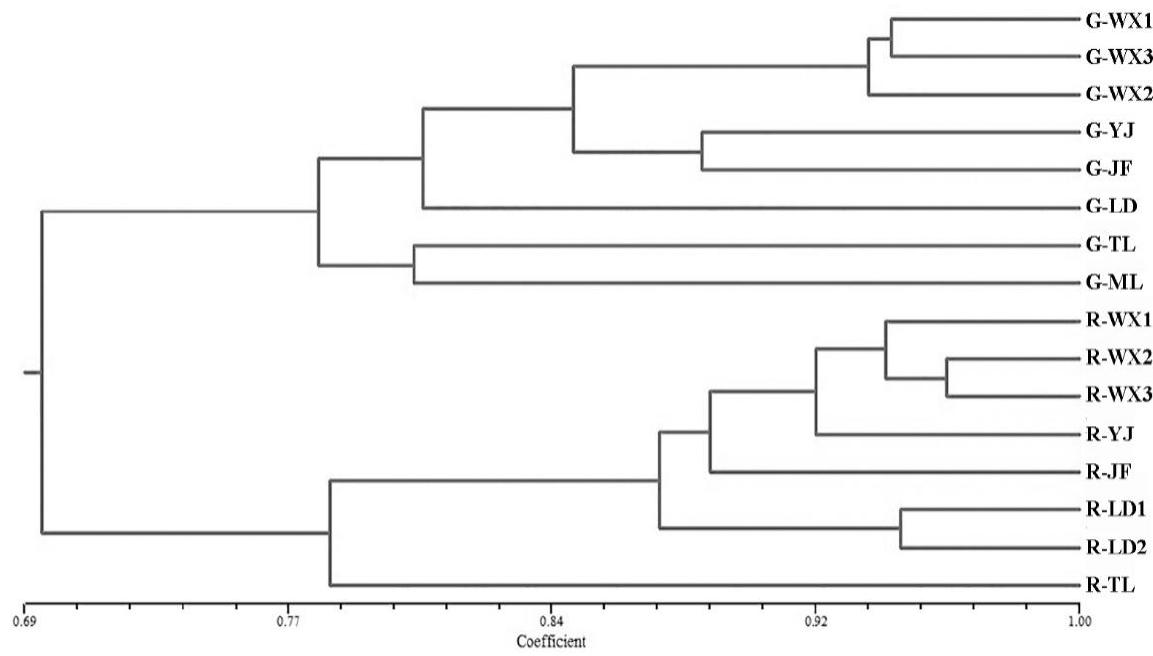
Figure 5. UPGMA tree of populations based on genetic distance.